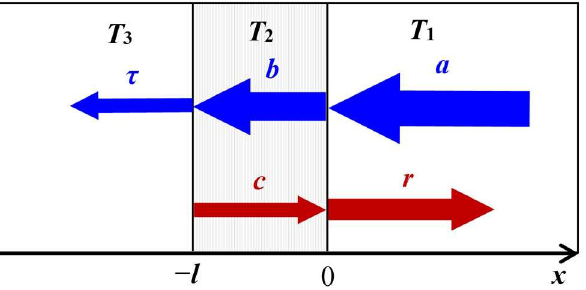
Figure 2. Geometry of propagation of the plane thermal waves in a three-layer object.